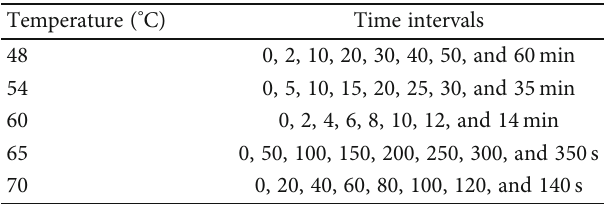
Table 1: Description of temperature and time intervals for collecting samples of inoculated fresh curd during quesillo making at 48-70 °